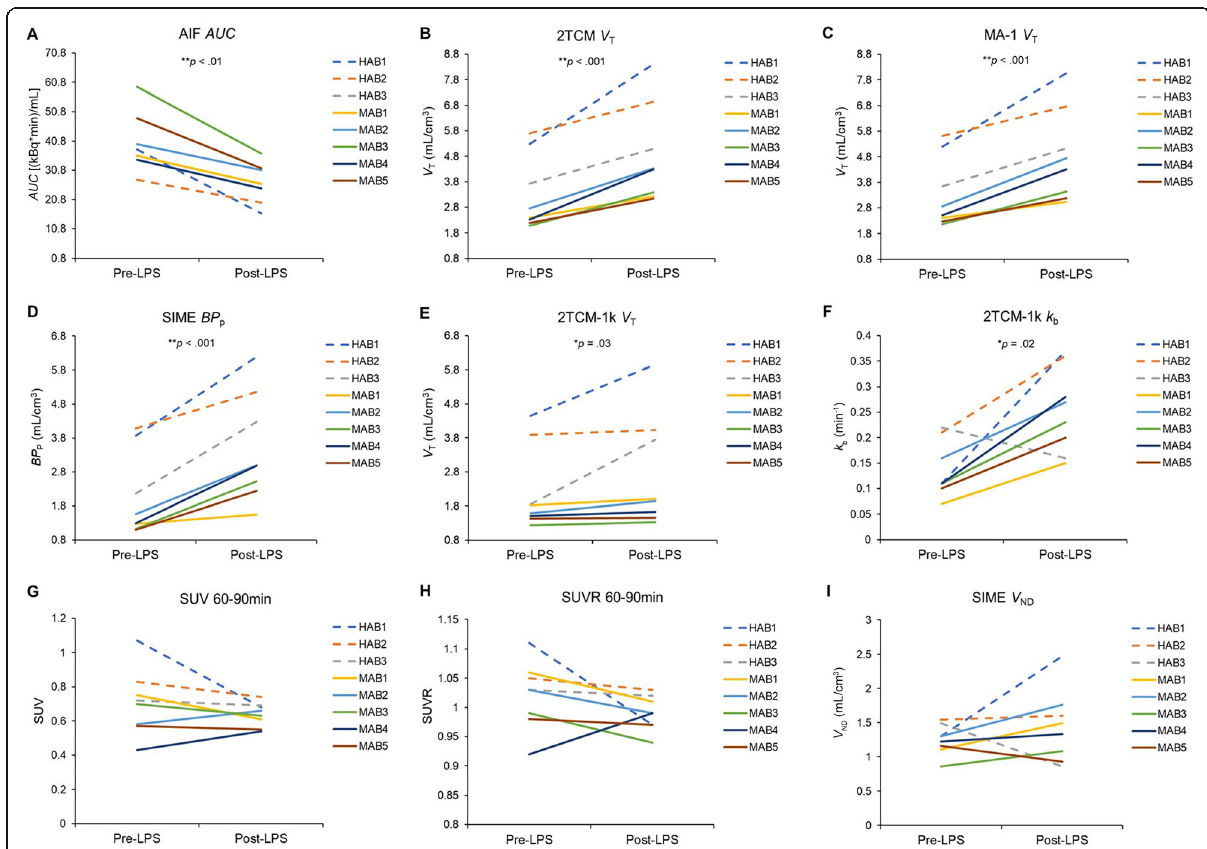
Fig. 2 Individual subject data are depicted as means across ROIs (HABs = dashed lines; MABs = solid lines). a AIF AUC. b 2TCM V T . c MA-1 V T . d SIME BP P . e 2TCM-1k V T . f 2TCM-1k k b . g SUV 60 – 90 min. h SUVR 60 – 90 min. i SIME V